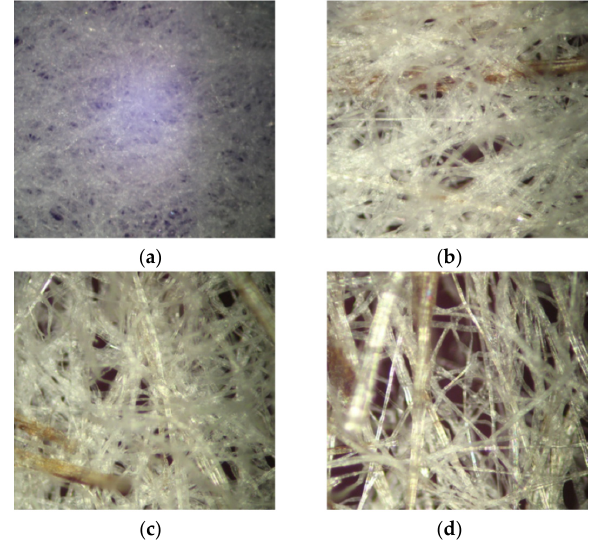
Figure 4. Effect of flax fiber (5 mm) content on the fibrous network structure, SD = 28.92 g/mm 2 . ( a ) 6g Kraft; ( b ) 1.5 g Flax (5 mm) + 4.5 g Kraft; ( c ) 3g Flax (5 mm) + 3 g Kraft; ( d ) 4.5 g Flax (5 mm) + 1.5 g Kraft.